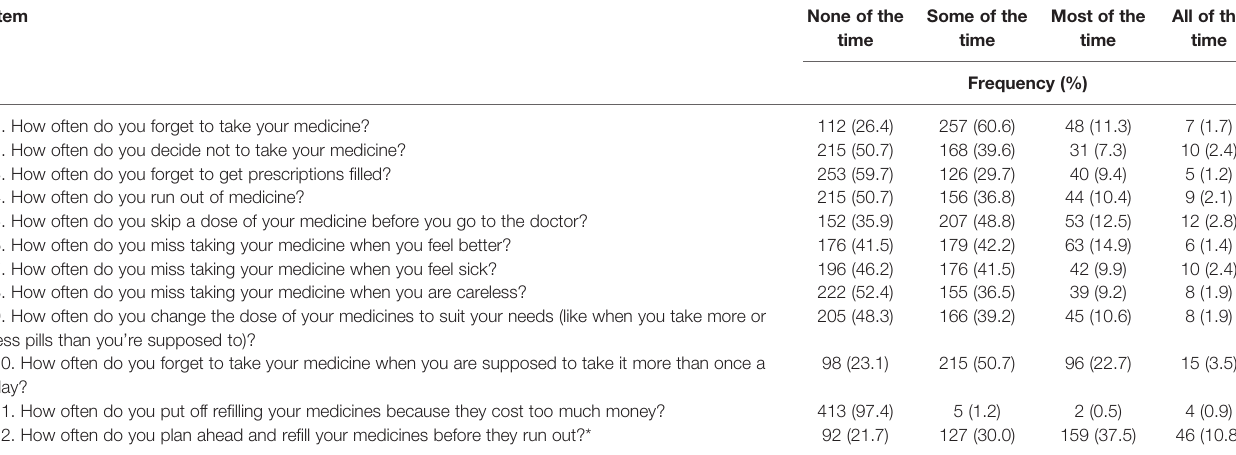
TABLE 6 | Adherence to Re fi lls and Medications Scale (ARMS) items assessing medication adherence among the respondents